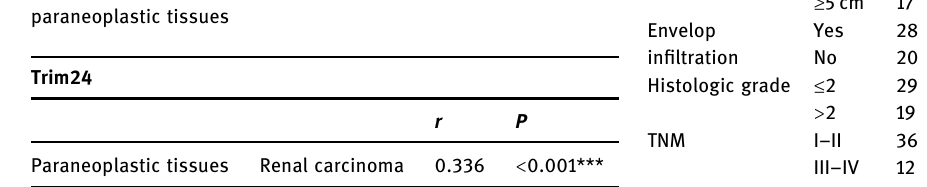
Paraneoplastic tissues